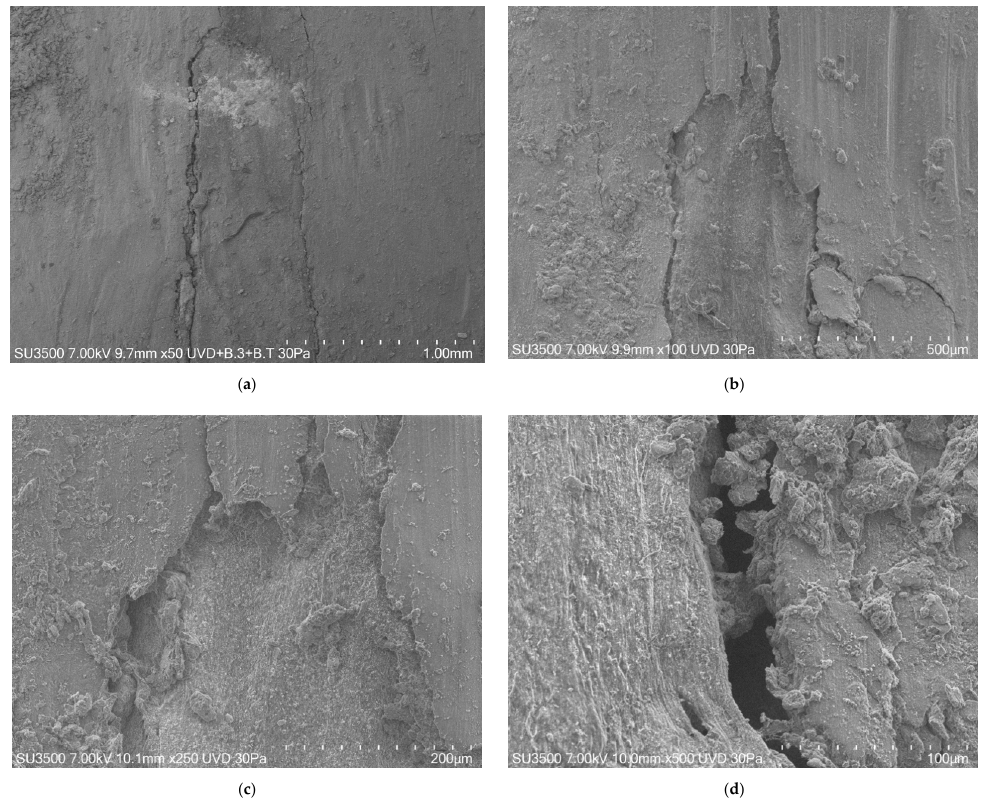
Figure 2. Gap observation of wet samples at four different magnifications. ( a ) 1 mm; ( b ) 500 μ m; ( c ) 300 μ m; ( d ) 100 μ m.